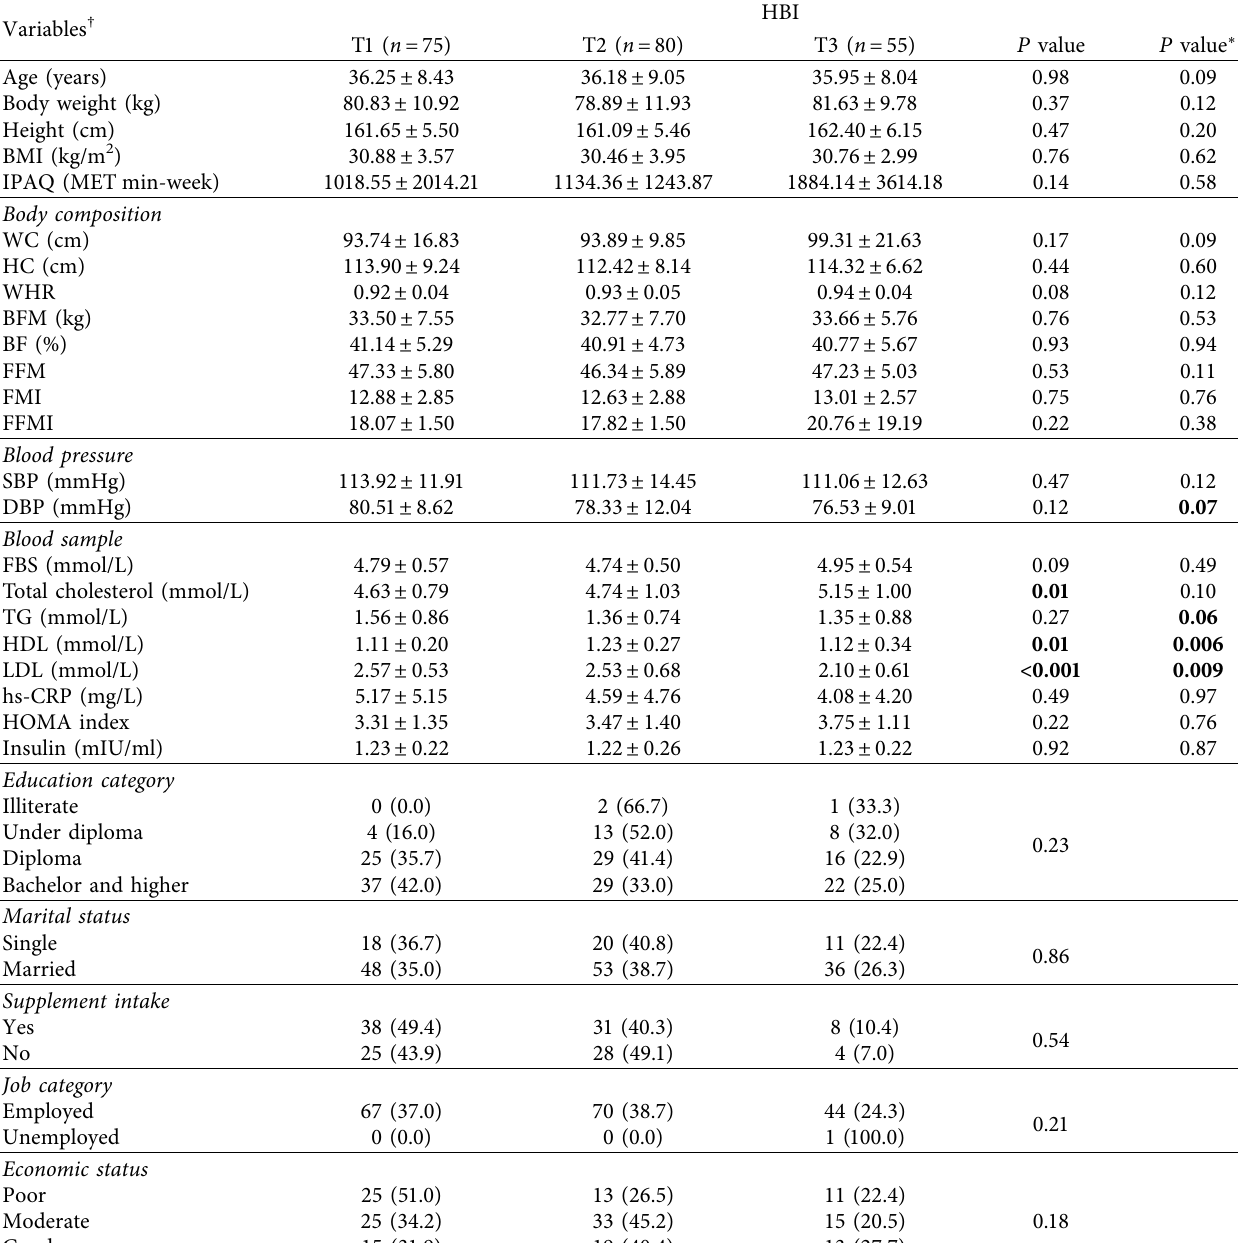
Table 2: Mean and SD of anthropometric body composition, blood parameters, and blood pressure according to tertiles of the healthy beverage